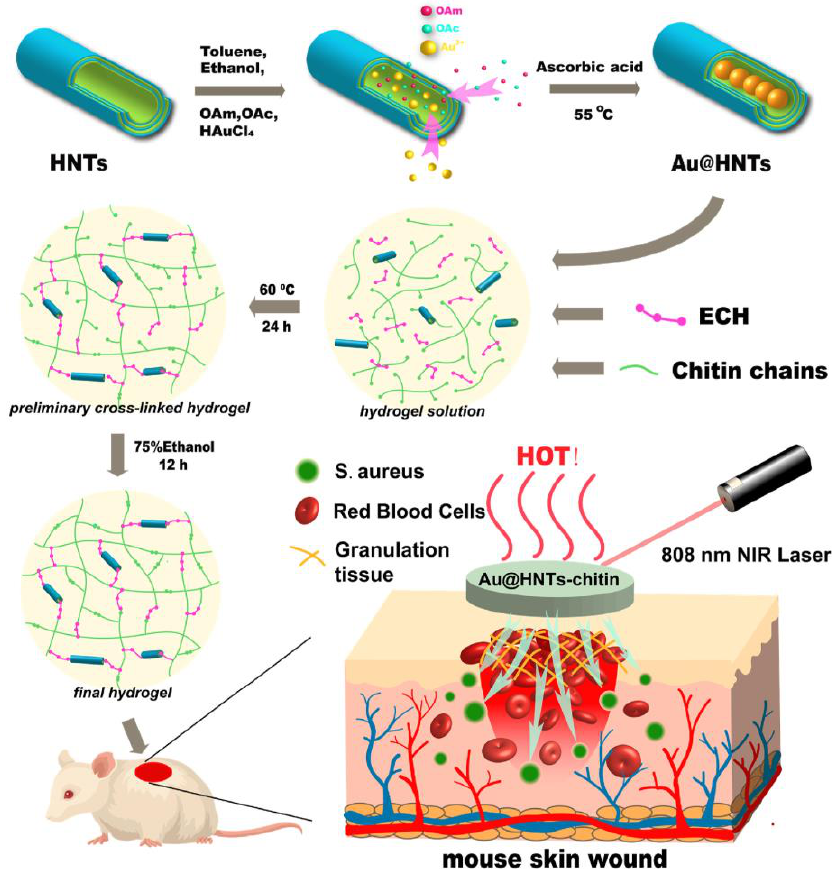
Figure 8. Schematic showing the preparation process and application of Au@HNTs-chitin hydrogel. Reproduced with permission from [72].